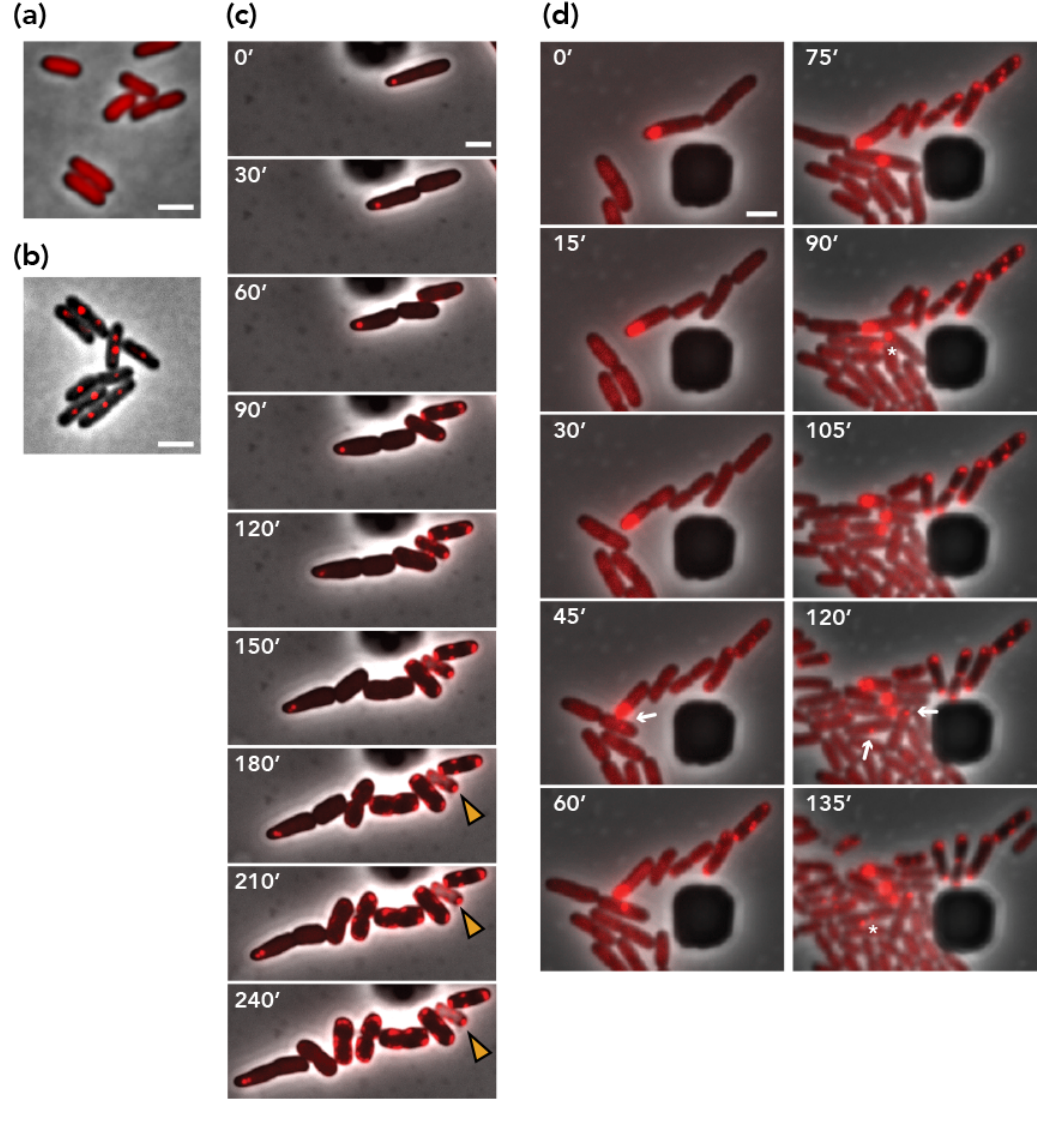
Figure 3. pESBL plasmid dynamics. ( a,b ) Representative image of E. coli cells expressing mCherry ‐ ParB pMT1 , in the absence ( a ) or presence ( b ) of parS pMT1+ pESBL. ( c ) Representative time ‐ lapse images showing mis ‐ segregation of ∆ par ∆ pnd parS pMT1+ pESBL. Arrowheads indicate dead cells that lost membrane integrity. ( d ) Representative time ‐ lapse images showing the re ‐ transfer of ∆ par ∆ pnd parS pMT1+ pESBL. Conjugational and vertical transfer events are indicated with arrows and asterisks, respectively. Bars = 2 μ m.